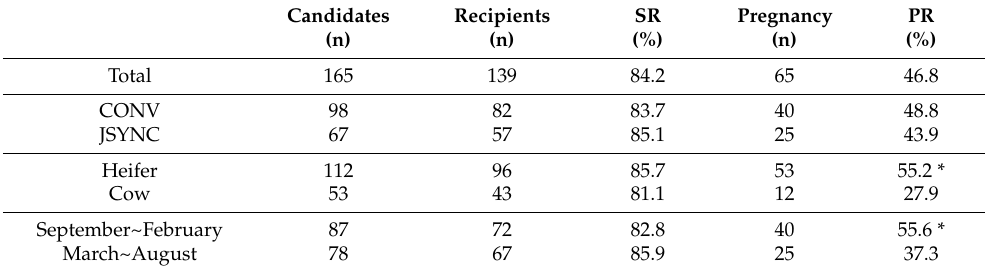
Table 1. Service rate and pregnancy rate according to synchronization protocols, parity, and season in all cows ( n = 165). Significant differences according to the z-test are expressed with * ( p < 0.05).